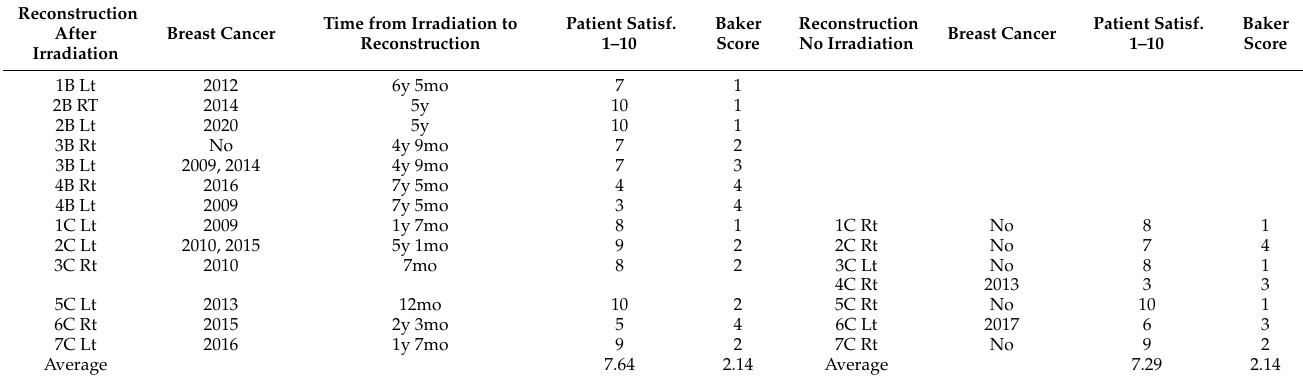
Table 3. Patients’ satisfaction and Baker score for breast reconstruction after prior breast irradiation (left) versus not (right). Reconstruction After Breast Cancer Time from Irradiation to Reconstruction Patient Satisf. 1–10 Baker Score Reconstruction No Irradiation Breast Cancer Patient Satisf. 1–10 Baker Irradiation